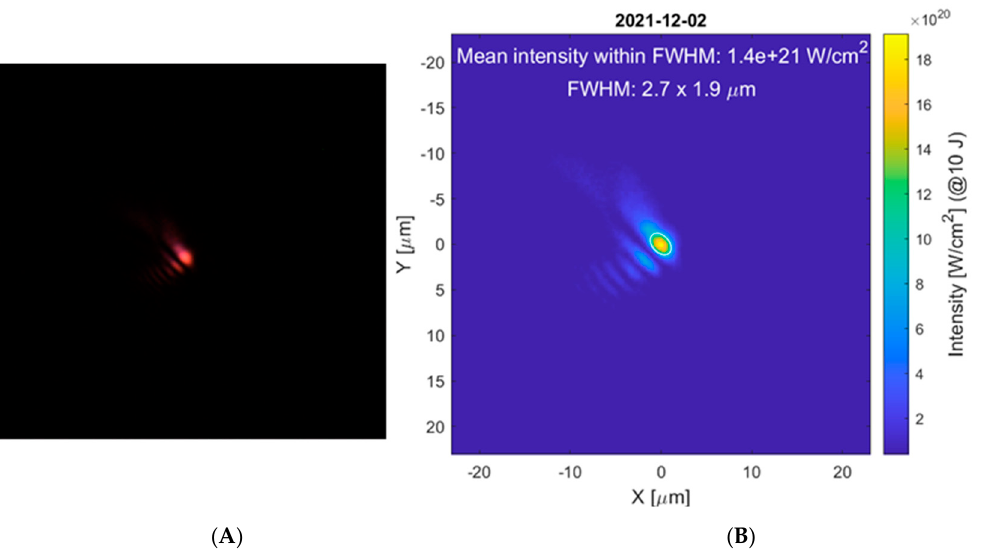
Figure 6. Typical example of focal spot at the ELIMAIA interaction chamber ( A ) and processed image for the calculation of the laser intensity on target ( B ). In this case, the energy at FWHM is 21.1% .